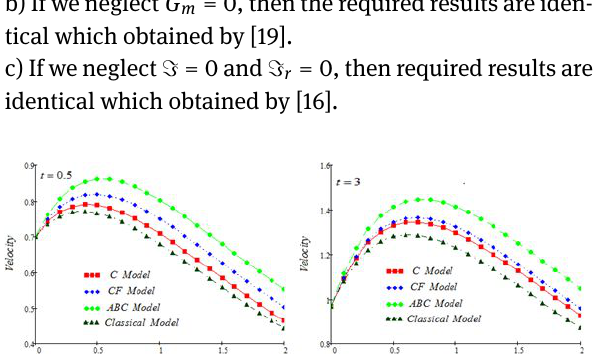
Figure 3: Velocity profile for FD’s with variation of Pr and Gr = 5,